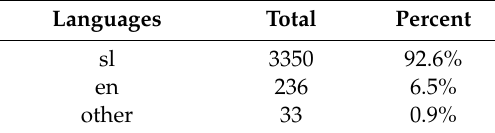
Table A49. Primary languages (si).